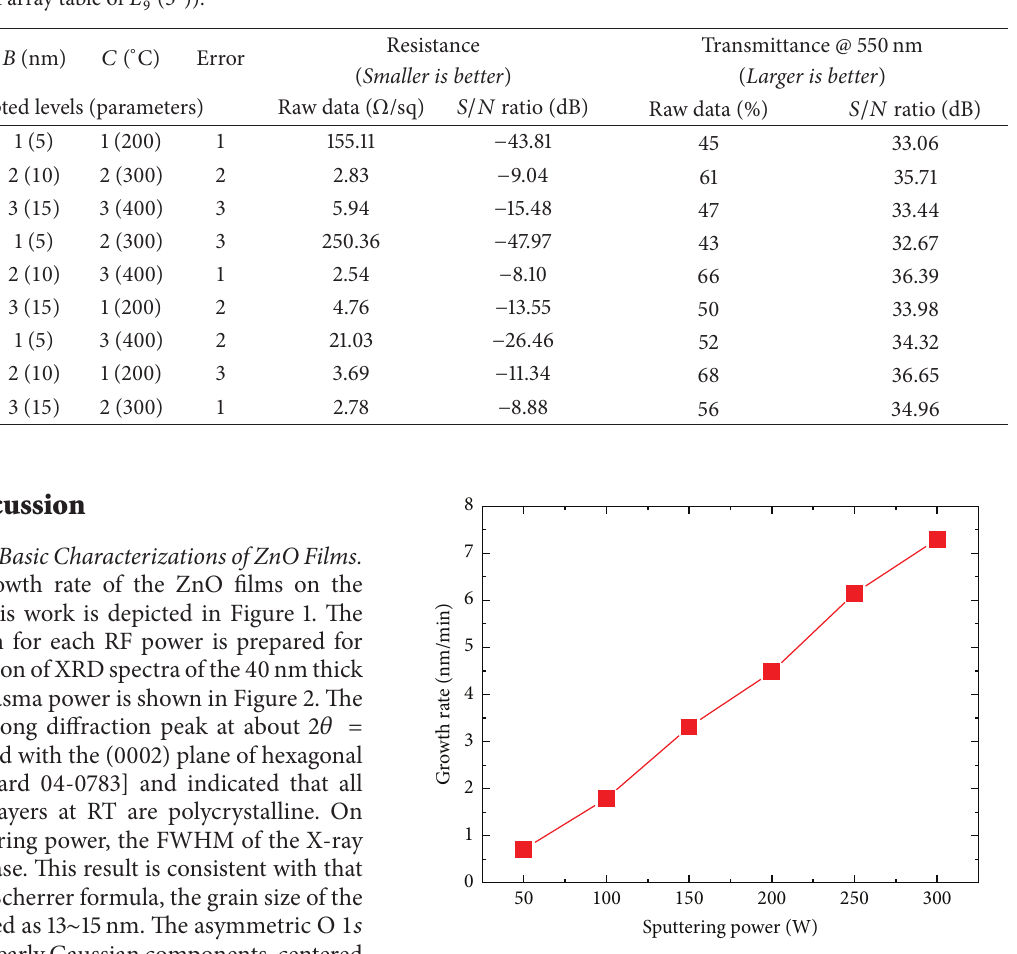
Figure 1: Growth rate of ZnO films grown at RT as a function of RF power.